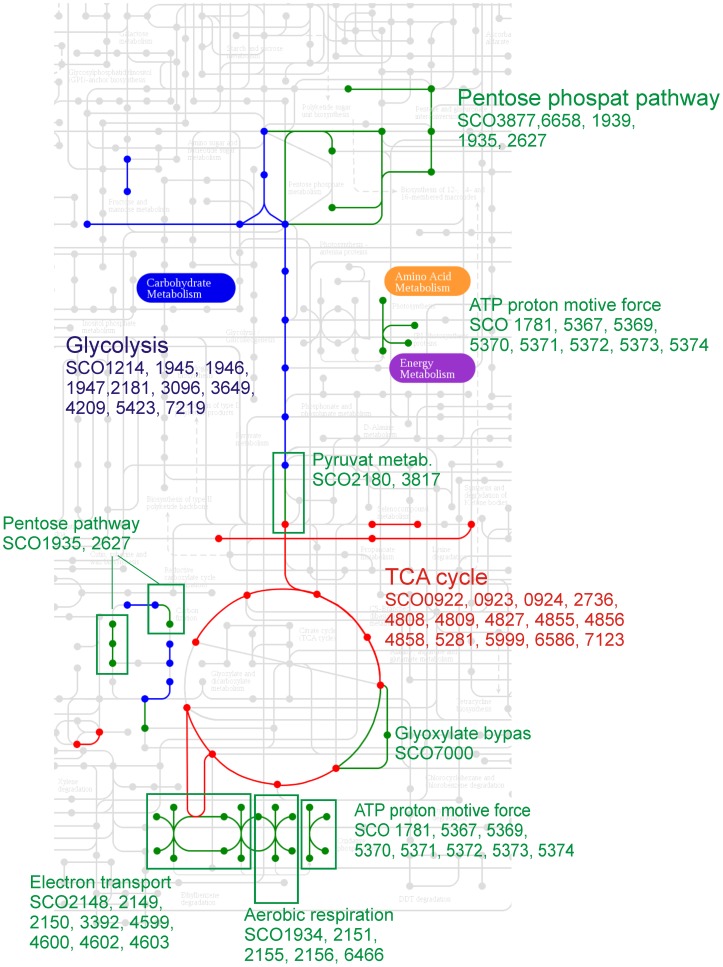
A visualization of genes significantly correlated with PC1, which are involved in primary energy metabolism.The basis of the illustration was made in KEGG mapping tool.